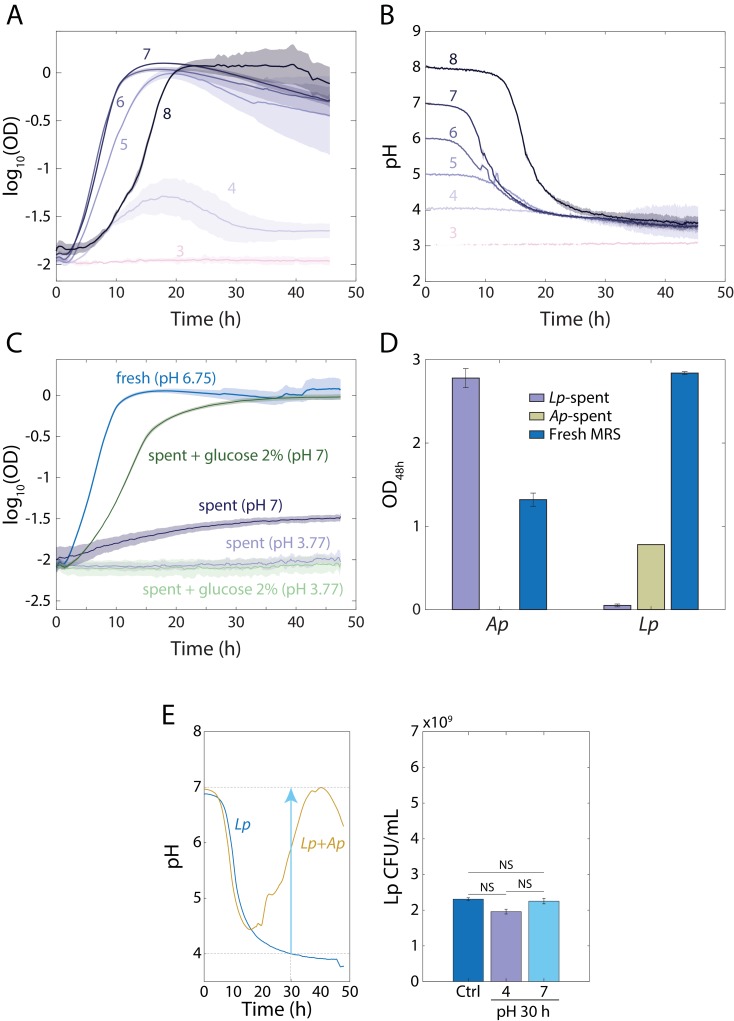
Growth of L. plantarum (Lp) in stationary phase is limited by the acidity of the medium.(A–B) Growth of Lp depends on the initial pH of the medium and it stops at a common pH of ~3.7. Logarithm of (A) OD or (B) pH (measured with the pH-sensitive dye BCECF) over time for cultures of Lp in MRS at various starting pH values (colors). Shaded regions are standard deviation (S.D.), n = 4. Data points were taken every 8.3 min. (C) Lp-spent media can support growth of bulk Lp culture when taken from pH 3.77 to pH 7 and it supports faster growth rates and higher carrying capacity when supplemented with glucose at pH 7. Error bars are S.D., n = 3. Data points were taken every 8.3 min. (D) Lp-conditioned medium supports growth of Ap to higher OD than fresh medium and Ap-conditioned medium supports growth of Lp to lower OD than fresh medium. Error bars are S.D., n = 3. p-values are from a Student’s two-sided t-test of the difference from growth in fresh MRS (***: p<0.001). (E) Increasing the pH of an Lp monoculture at t = 30 h from 4 to 7 to mimic the pH increase in Lp-Ap co-culture (left panel) does not lead to significant increase in CFU/mL with respect to a control. A 48-hr-old culture with no changes in pH was used as a control (Ctrl.). Error bars are S.D. for each condition, n = 3. p-values are from a Student’s two-sided t-test of the difference between the cultures (NS, not significant, p>0.0167).